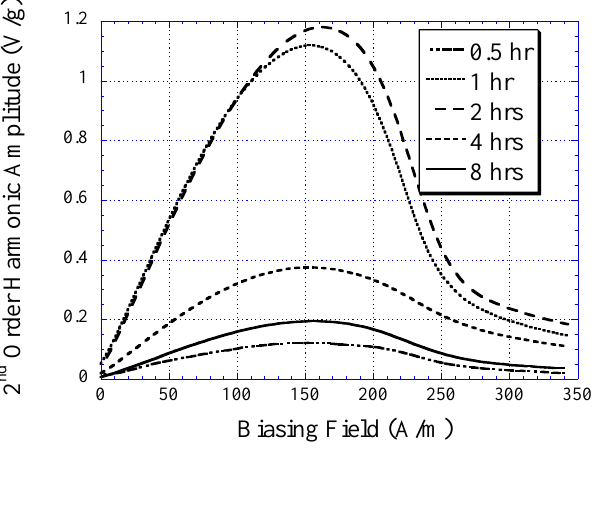
Figure 4. The 2nd-order harmonic fields exhibited by electroplated nickel-iron alloys plated for 0.5, 1, 2, 4, and 8 h normalized to the sample